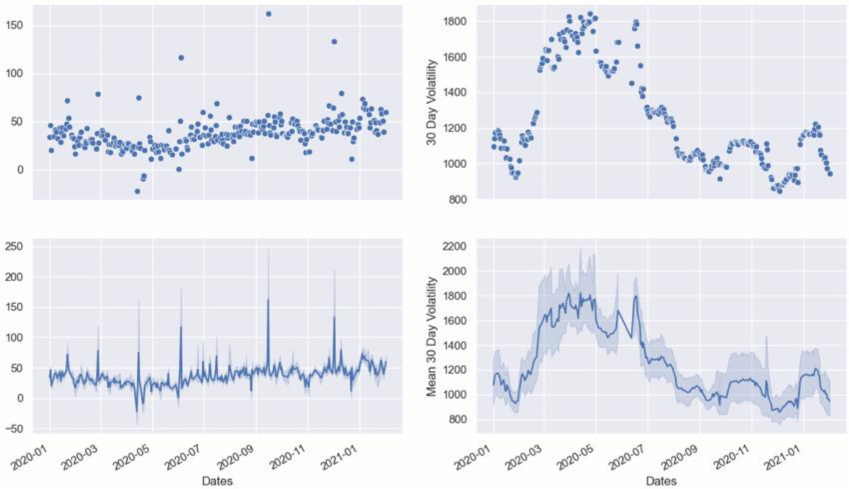
Figure 7. This figure represents the intraday price levels for German power including its’ confidence levels on the left side and the 30 day volatility including its’ confidence levels on the right side. Figures 7 and 8 got generated using the same code in